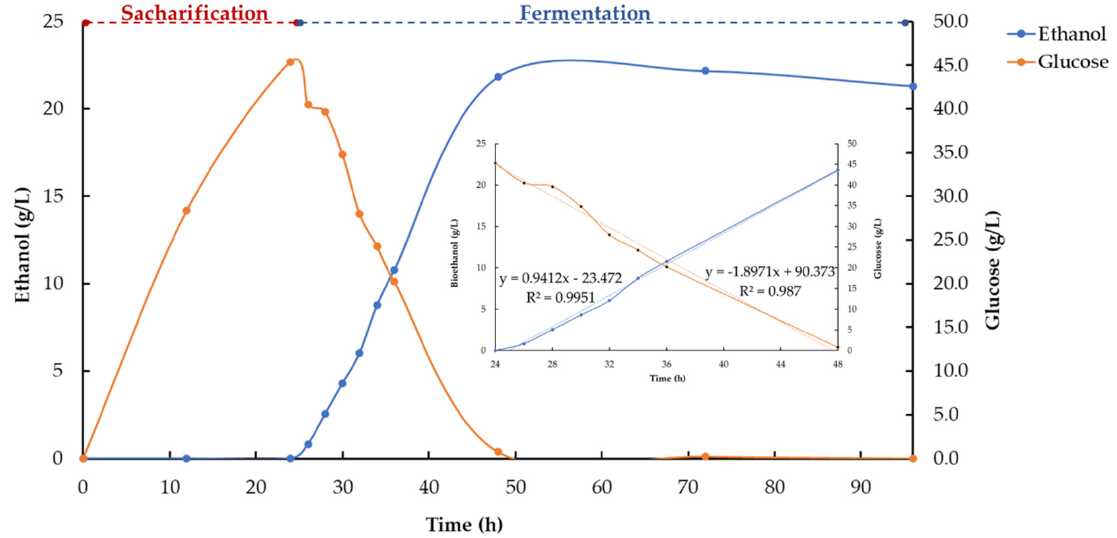
Figure 5. Process of pre-saccharification kinetics and simultaneous fermentation (PSSF). with a yield in the process of 57.32% (Figure 6). Therefore, the fermentation process can